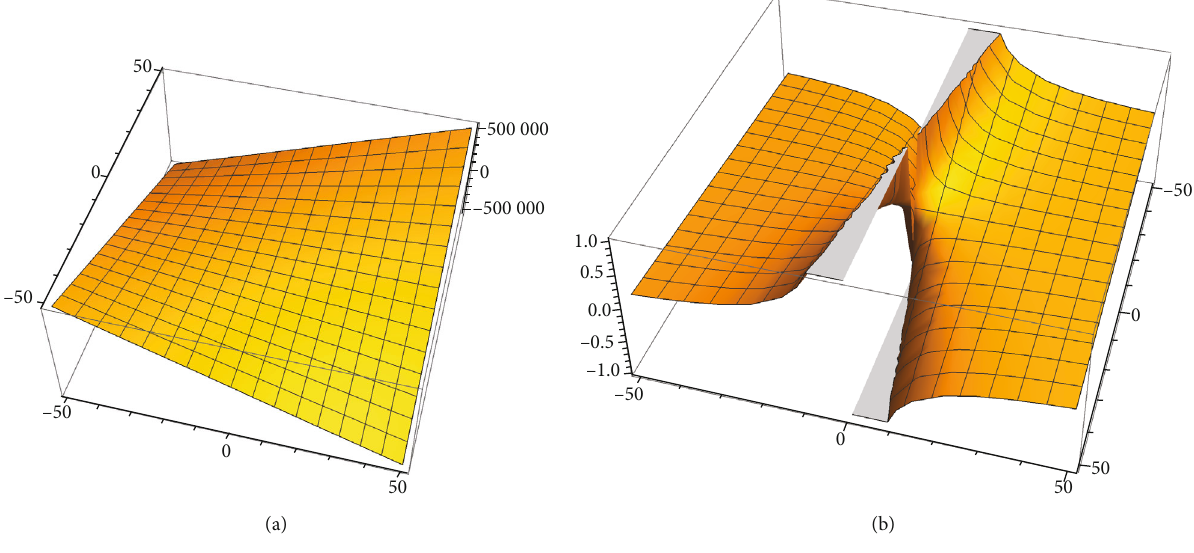
Figure 1: 3D representation of X for α = 1 (a) and of the exact solution